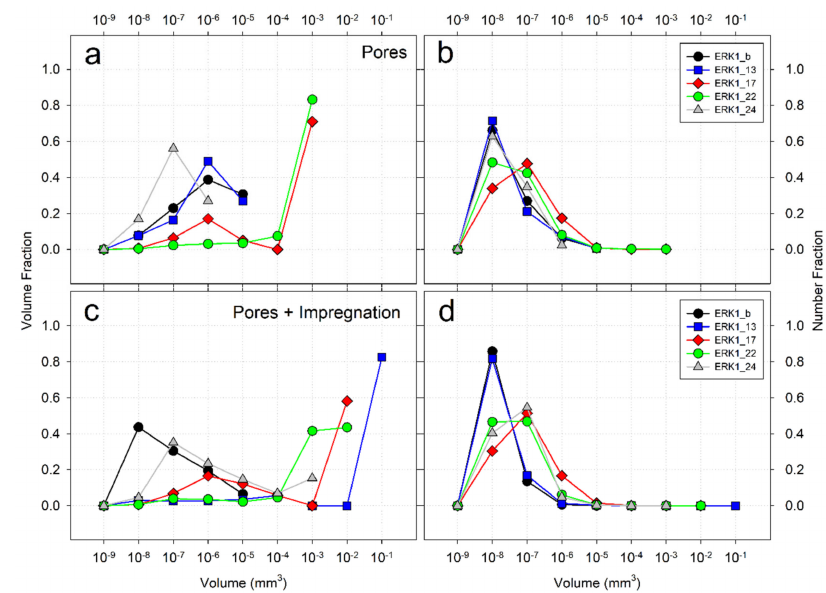
Figure 6. Results of the pores ( a , b ) and pores + impregnation ( c , d ) morphology analysis: Volume Fraction ( a , c ) is calculated as the sum of the volume of the single elements (pores or pores + impreg- nation) having a given size range over the total volume of the investigated phase; Number Fraction is computed as the number of pores or pores + impregnation having a given size range over the total number of pores.